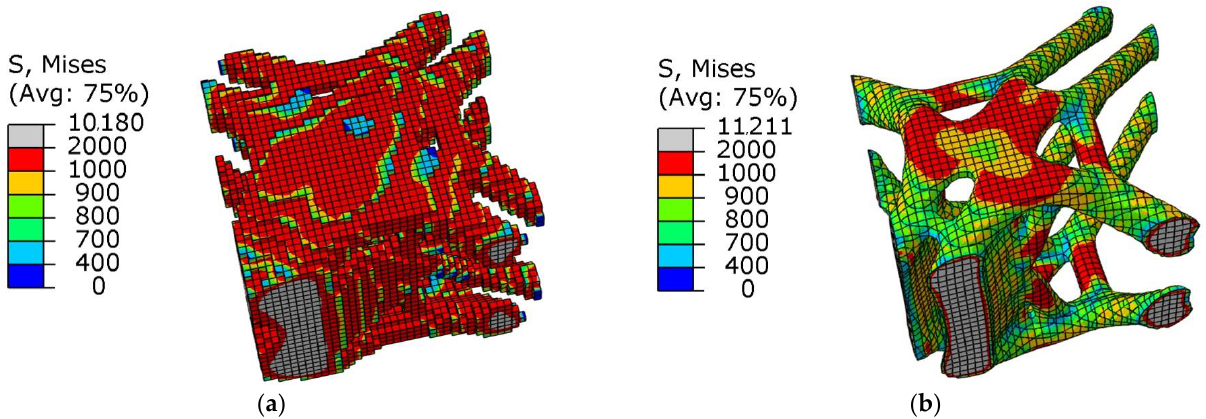
Figure 14. The stress nephograms of the design domain of the optimized joint under the shear condition: ( a ) BESO; ( b ) SIMP. Table 2. Comparison of optimization results of shear conditions.